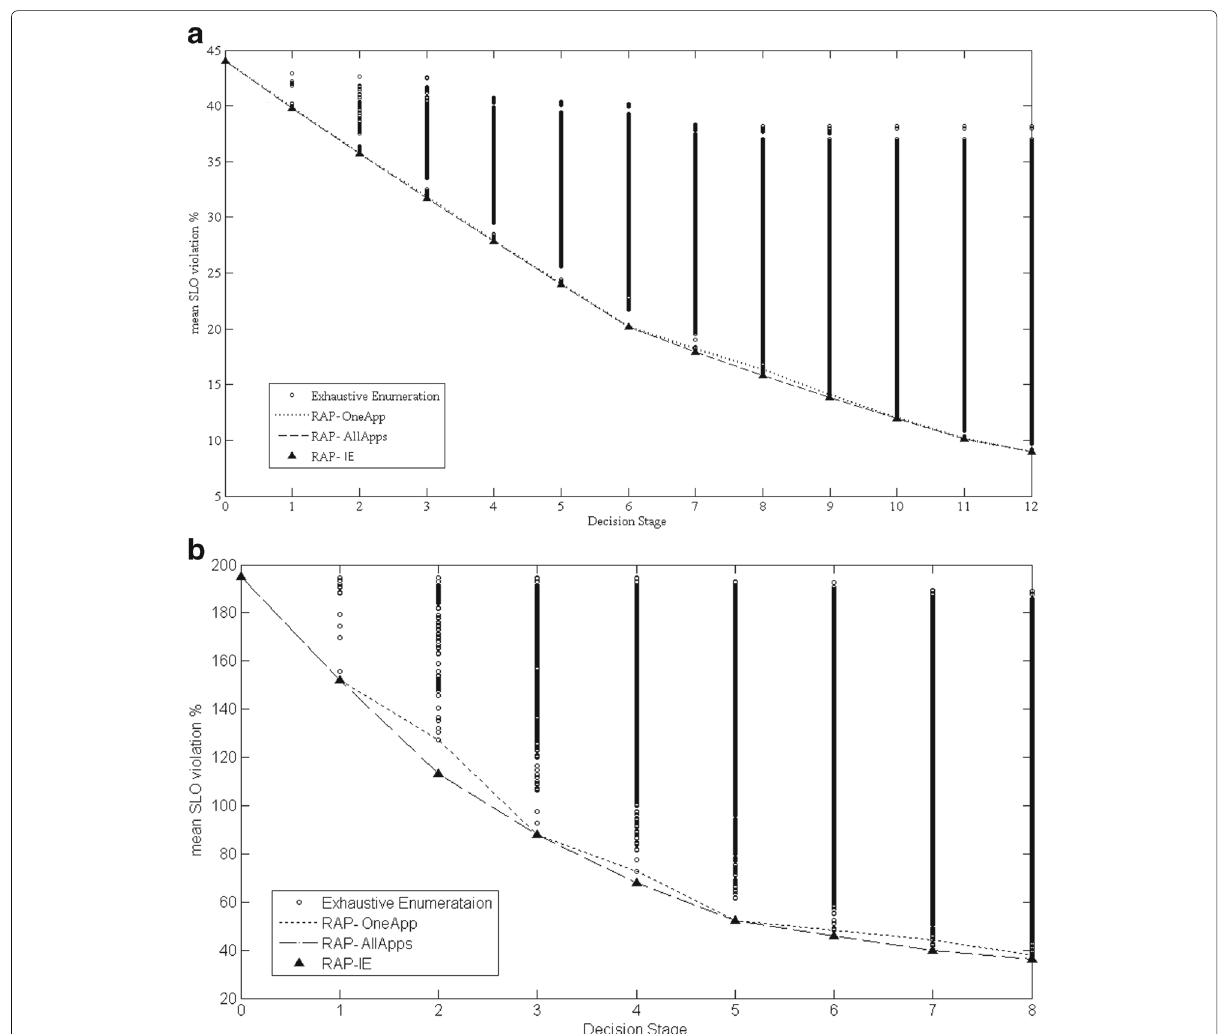
Fig. 5 Optimality of RAP variants. a Exponential session arrivals. b Bursty session